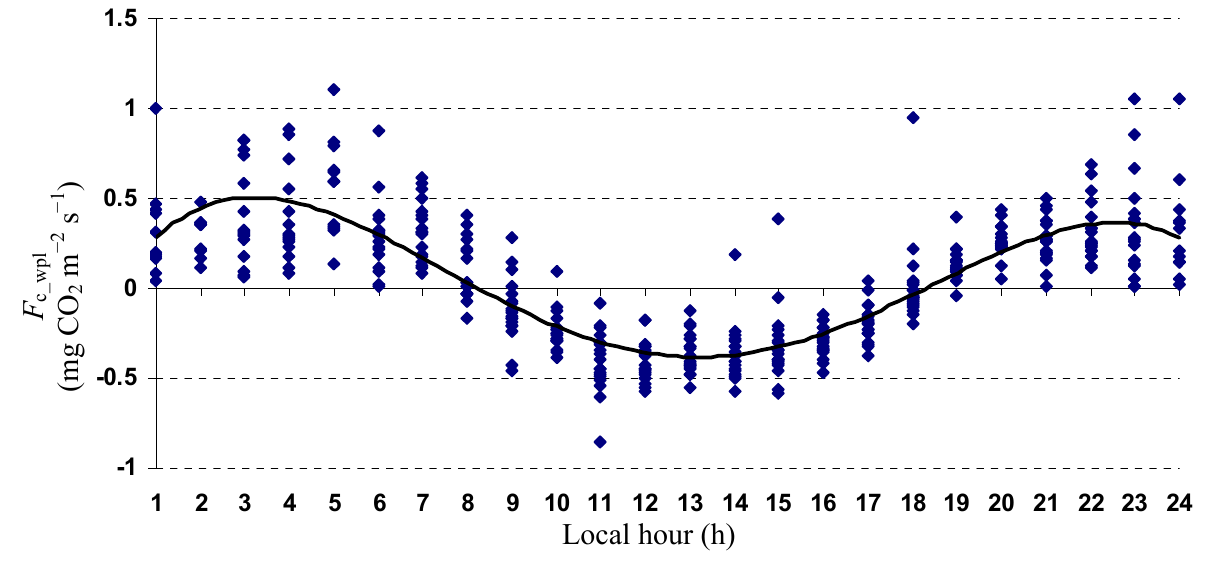
Figure 4. A quartic function fitted to F F (mg CO m − 2 s − 1 ) = 0.3575 h – 0.077 h 2 ± 0.0049 h 3 – 9 × 10 -5 h 4 ; ( R 2 c_wpl 2 SE = 0.1905; n = 412; P <